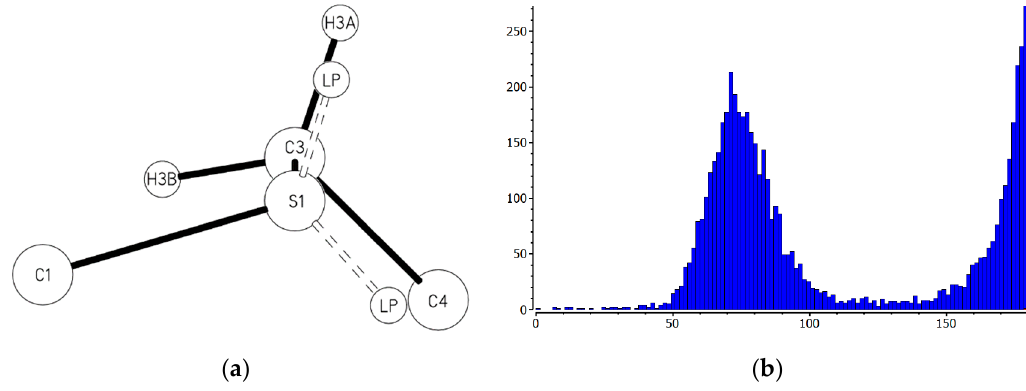
Figure 3. The conformation of the C1-S1-C3-C4 fragment in 8 (LP–positions of lone electronic pairs, ( a )) and the distribution of corresponding torsion angles in the C-S sp3 -C sp3 -C sp3 fragments retrieved from the Cambridge Structural Database ( b ).